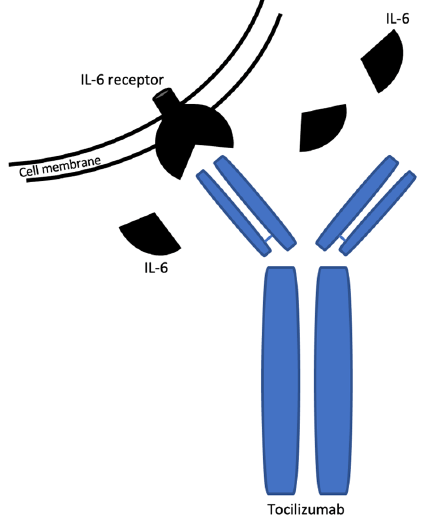
Figure 2. Tocilizumab schematic structure and mechanism of action.